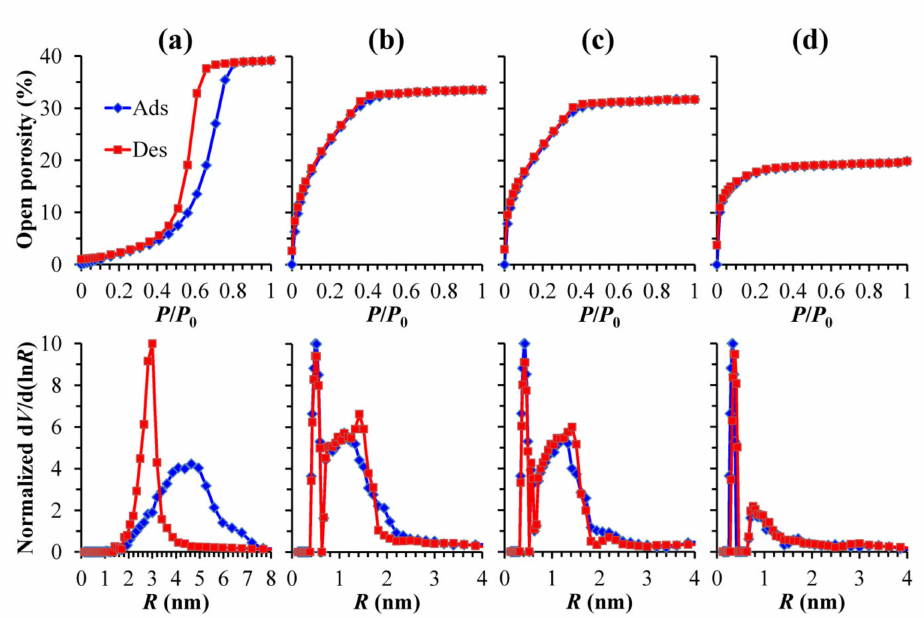
Figure 7. Adsorption–desorption isotherms and pore size distribution in the low- k films prepared from